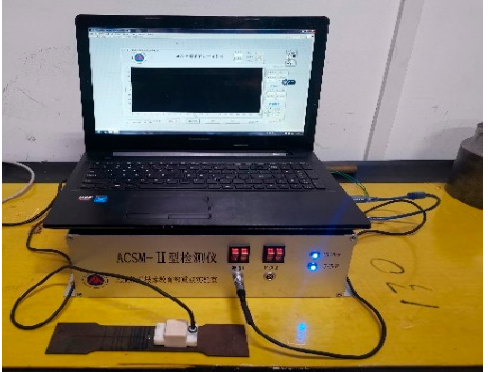
Figure 18. ACSM stress measuring instrument physical drawing.